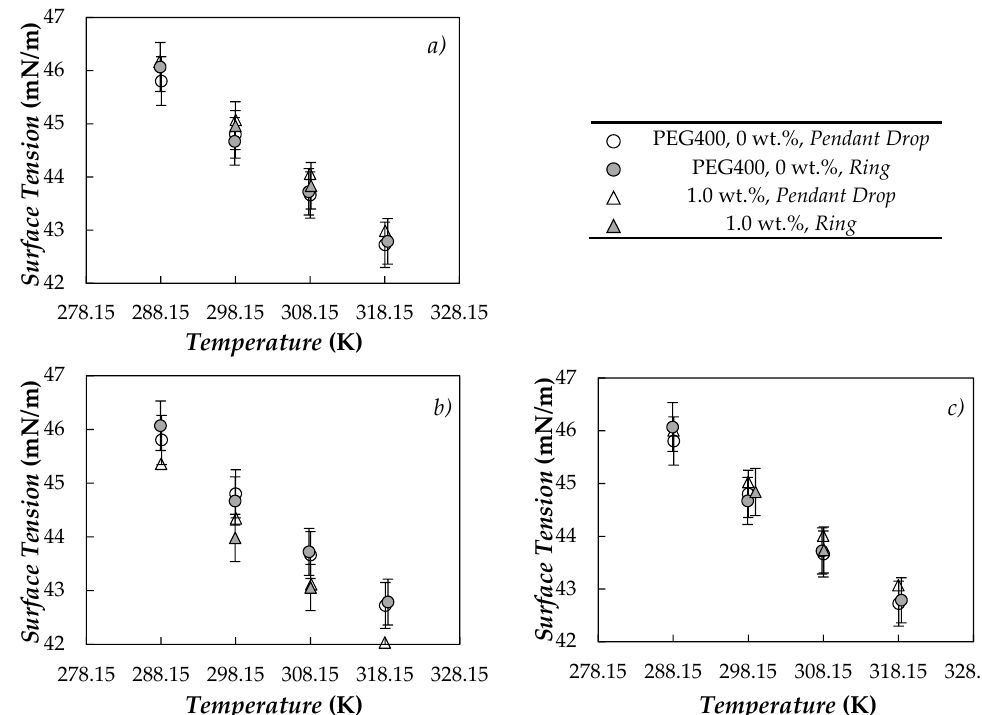
Figure 9. Temperature dependence of surface tension obtained for neat PEG400 and nanofluids prepared at the highest nanoparticle concentration, 1 wt.%, of ( a ) CB, ( b ) nD87 and ( c ) G/D-p.